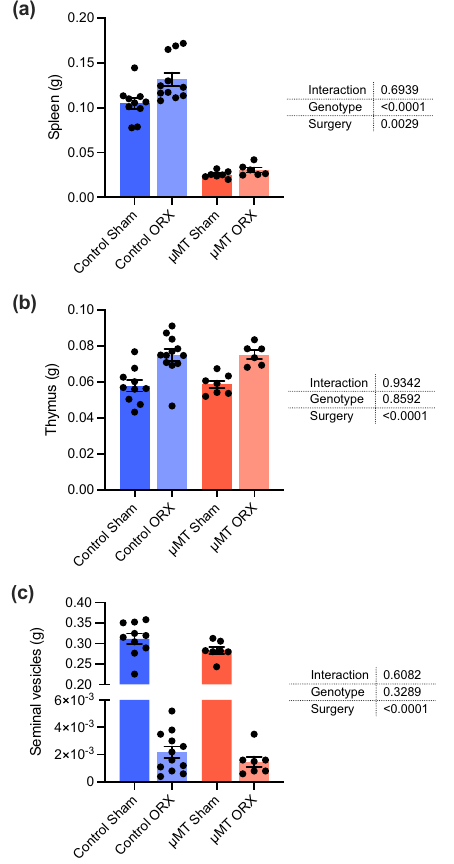
Figure 1. Weights of immunological and androgen-sensitive organs in the µMT/castration model. µMT and control Apoe -/- mice were castrated (orchiectomized, ORX) or sham-operated (Sham) at 3 weeks of age and fed a high-fat diet between 8 and 16 weeks of age. The weights of the spleen (a) , the thymus (b) , and the seminal vesicles (c) were recorded at the finish at 16 weeks of age (n = 6–12/group). Data were analyzed by 2-way ANOVA. Bars indicate means, error bars indicate SEM, and circles represent individual